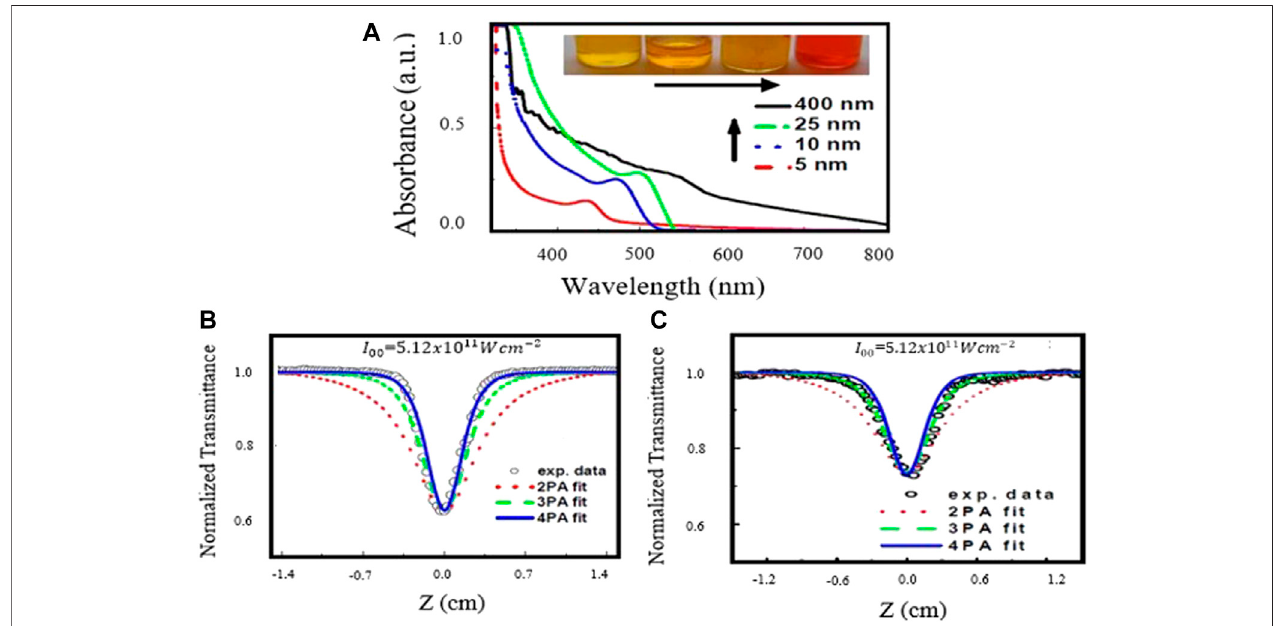
FIGURE 13 | (A) CdSe QDs Optical absorption spectra of various sizes such as 5 nm, 10 nm, 20 nm, 400 nm (B) CdSe QDs (5 nm) open aperture Z-scan curve. (C) Open aperture Z-scan curve of 400 nm CdSe QDs. Lines show the theoretical fi t with multiphoton absorption coef fi cients [137].